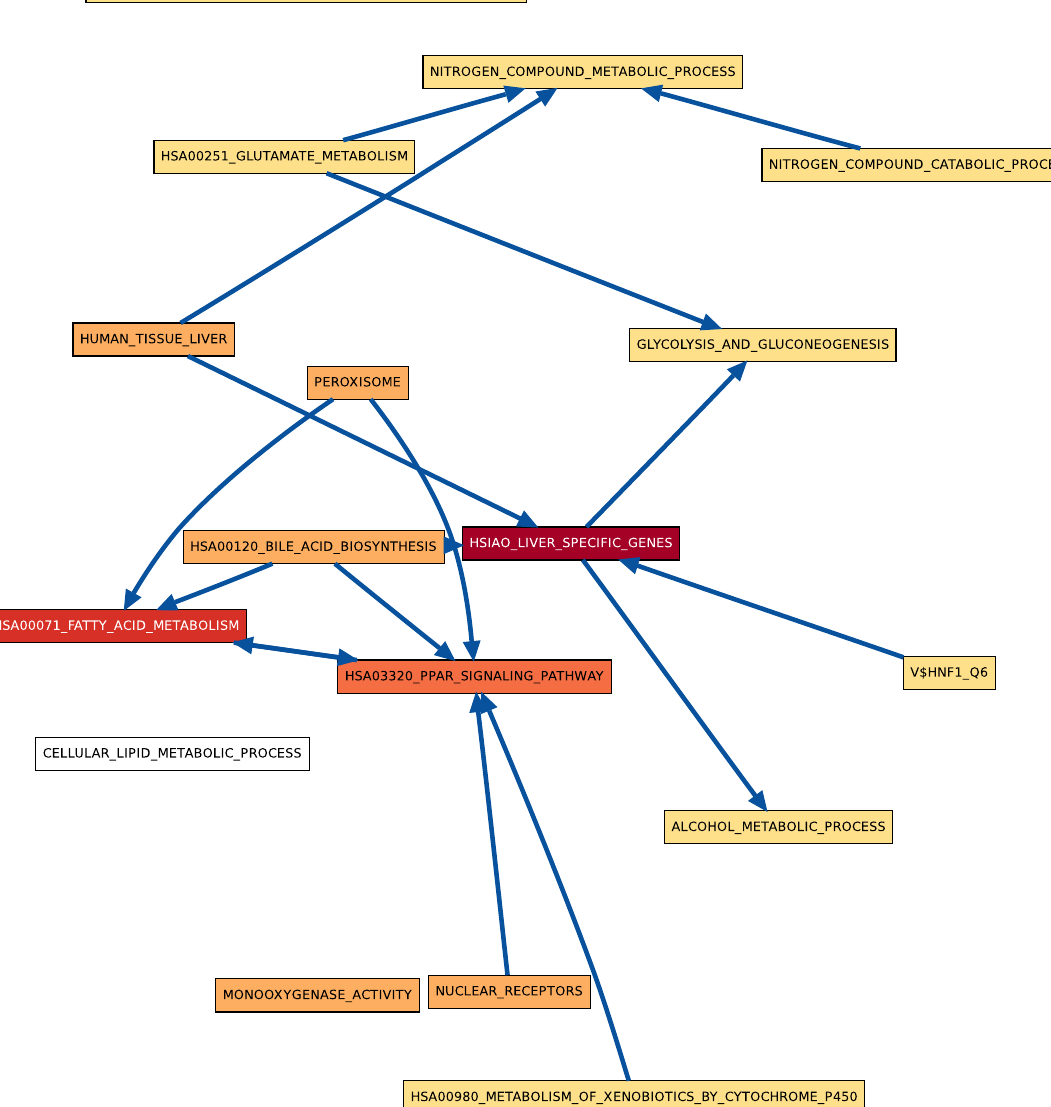
Figure 2. CS vs. HM CBPLN on day 2.